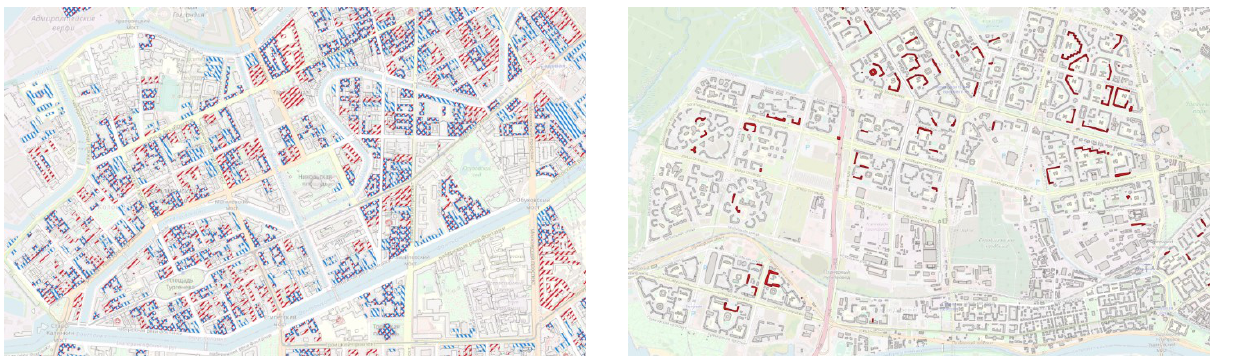
Figure 9. Visualization of HIV cases reported in 2018 in Primorsky district of St. Petersburg (base map © OpenStreetMap contributors) To visualize the number of infected people over all the years (or other period) of monitoring, point geometries can be used. In the Fig. 10 size of the point markers depend on the number of infected people at the address.